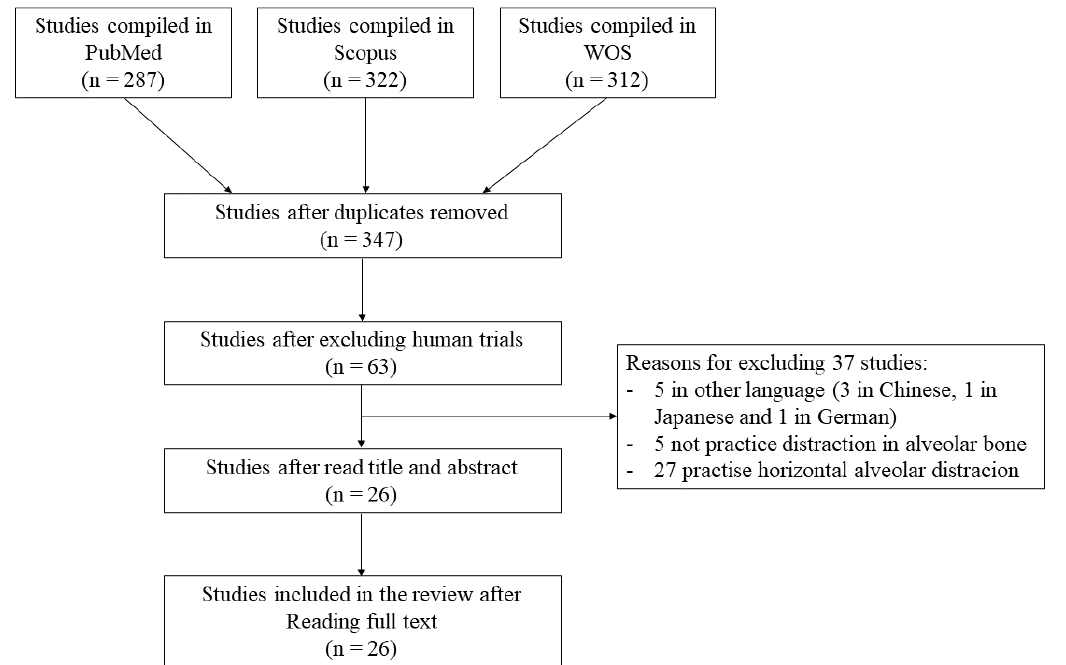
Figure 1. Flow chart of the selected studies .